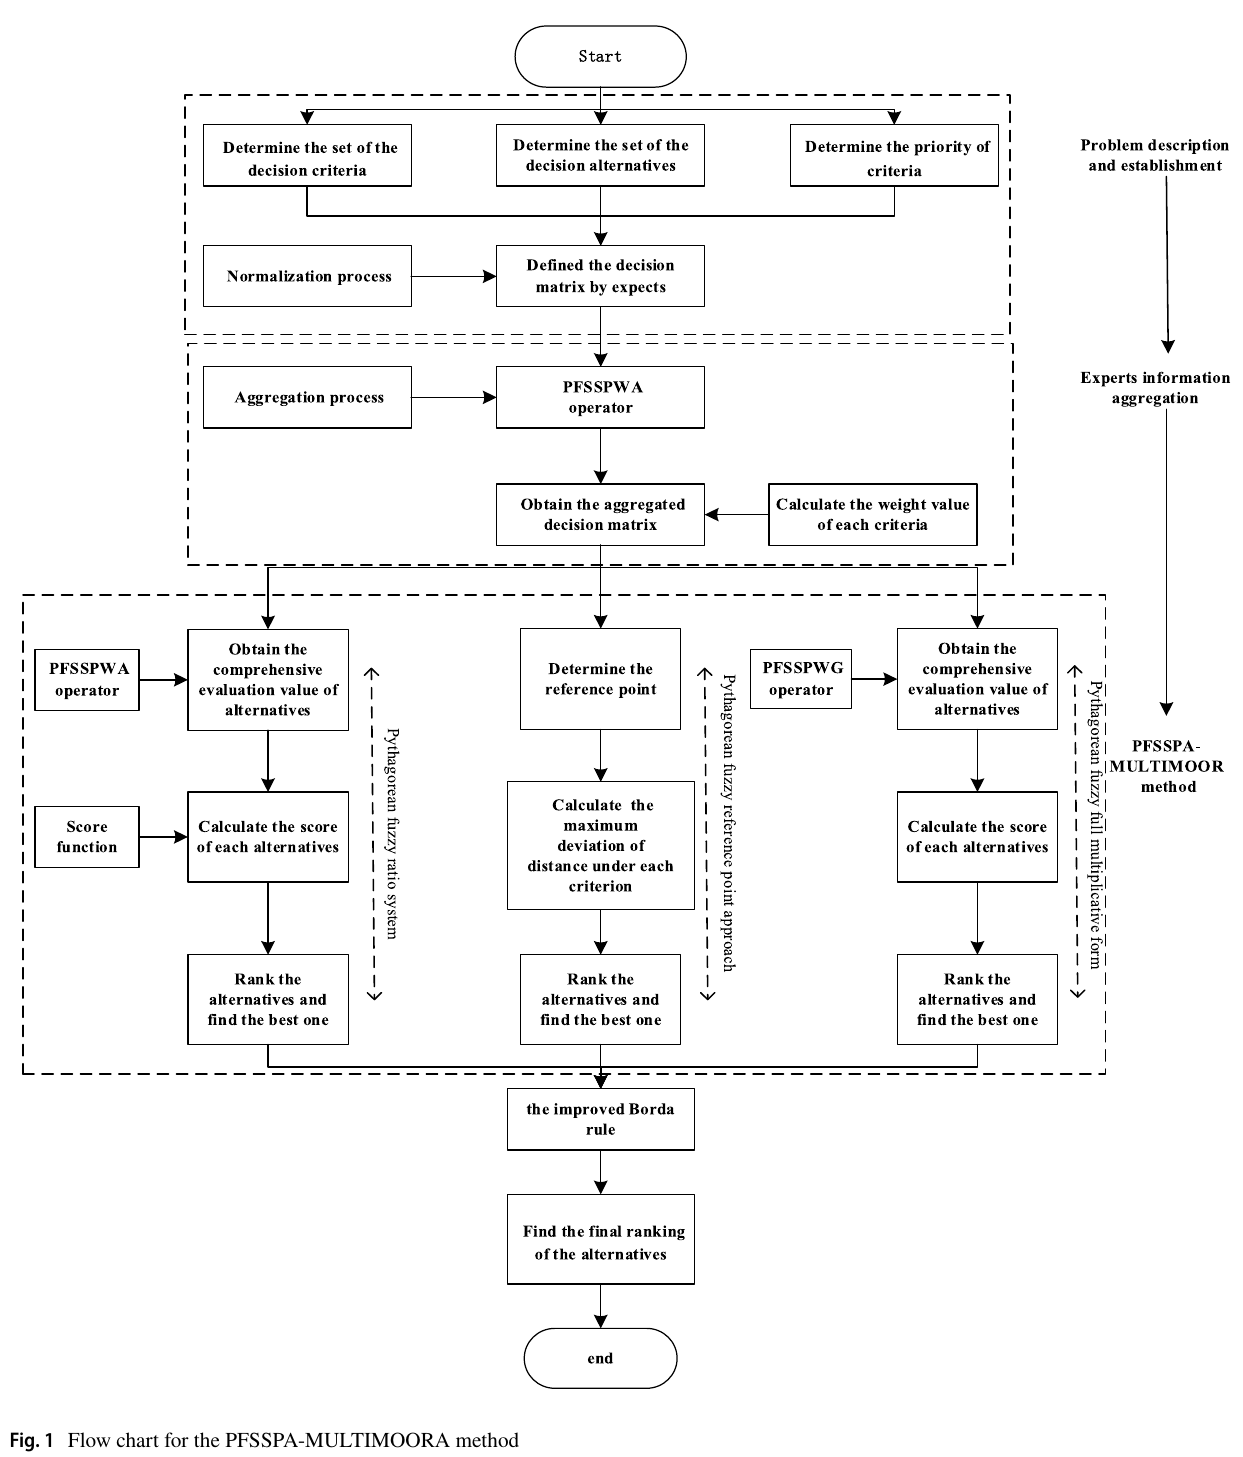
Fig. 1 Flow chart for the PFSSPA-MULTIMOORA